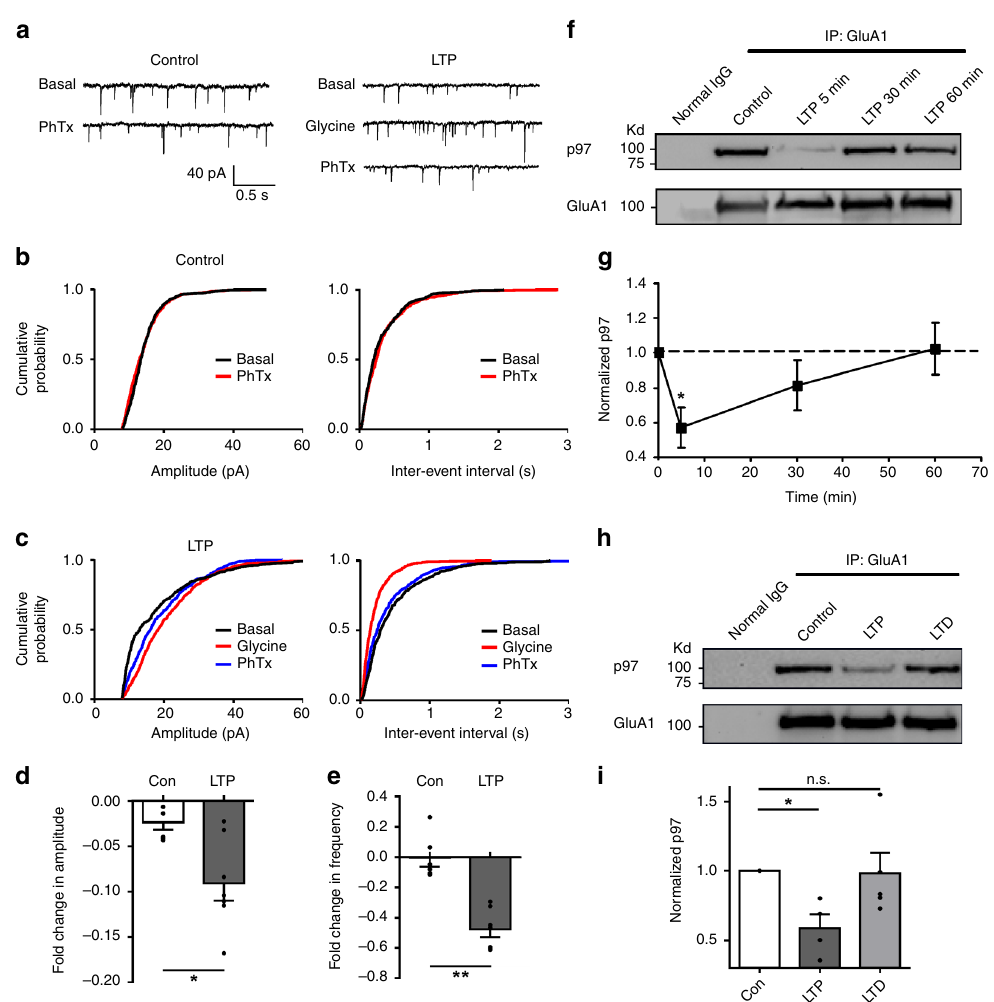
Fig. 5 Synaptic insertion of native GluA1-homo AMPARs is associated with a rapid dissociation of p97 during LTP in cultured hippocampal neurons. a – c Representative traces ( a ) and cumulative probability plots of the amplitude and inter-event intervals of mEPSCs ( b , c ) from individual neurons in the absence and presence of PhTx show that bath application of glycine (200 μ M, 3 min) produced chemical LTP as evident by the increased amplitude and frequency of mEPSCs (LTP) in comparison with that of control (Control). Bath application of PhTx (10 μ M; 5 min after the formation of whole-cell con fi guration (basal) or glycine application (LTP)), while having no observable effect on basal mEPSCs ( b ; Control; PhTx), reduced the LTP-induced increase in both amplitude and frequency of mEPSCs ( c ; LTP; PhTx), suggesting that there was a rapid insertion of the native GluA1-homo AMPARs following the LTP induction. d , e . Bar Graphs of grouping data from six to seven neurons demonstrate that PhTx only reduced both amplitude ( d ) and frequency ( e ) of mEPSCs after LTP, but not at the control (Con) conditions (Control: n = 6 cells; LTP: n = 7 cells; * p < 0.05, ** p < 0.01, two-tailed t test). f – i Sequential immunoblotting of p97 and GluA1 following co-IP with anti-GluA1 antibodies show that there was a transient and time-dependent dissociation of p97 from GluA1 immediately following the induction of LTP ( f , g , n = 6 repeated experiments, F = 4.256, p = 0.0147, one-way ANOVA, * p < 0.05, post hoc test), but not after induction of LTD ( h , i , 10 min after induction of LTP or LTD, n = 5 repeated experiments; F = 4.582, p = 0.0357, one-way ANOVA, * p < 0.05, n.s. not signi fi cant, post hoc test). The error bars represent